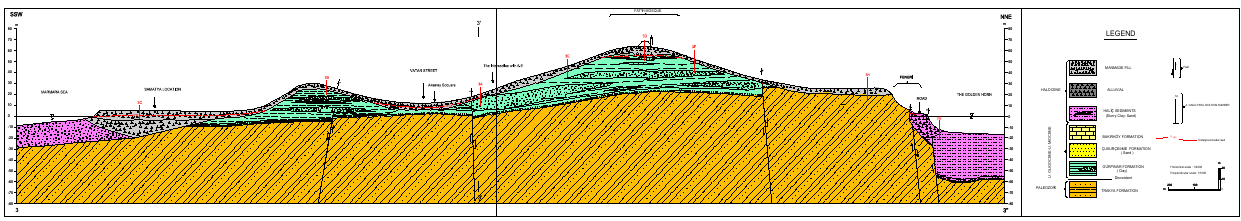
Figure 5. The location of the points on the 3-3’cross section where the 1D and 2D analyses were performed (Ince et. al., 2008)